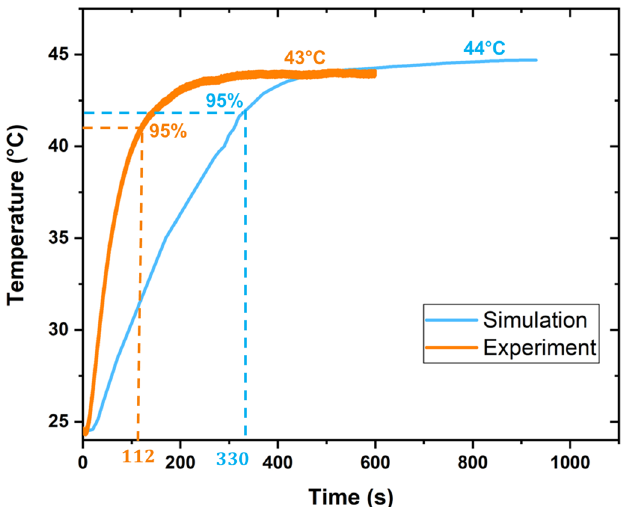
Figure 9. Time evolution of the measured and simulated temperatures performed on the tablecloth with an optimized design.